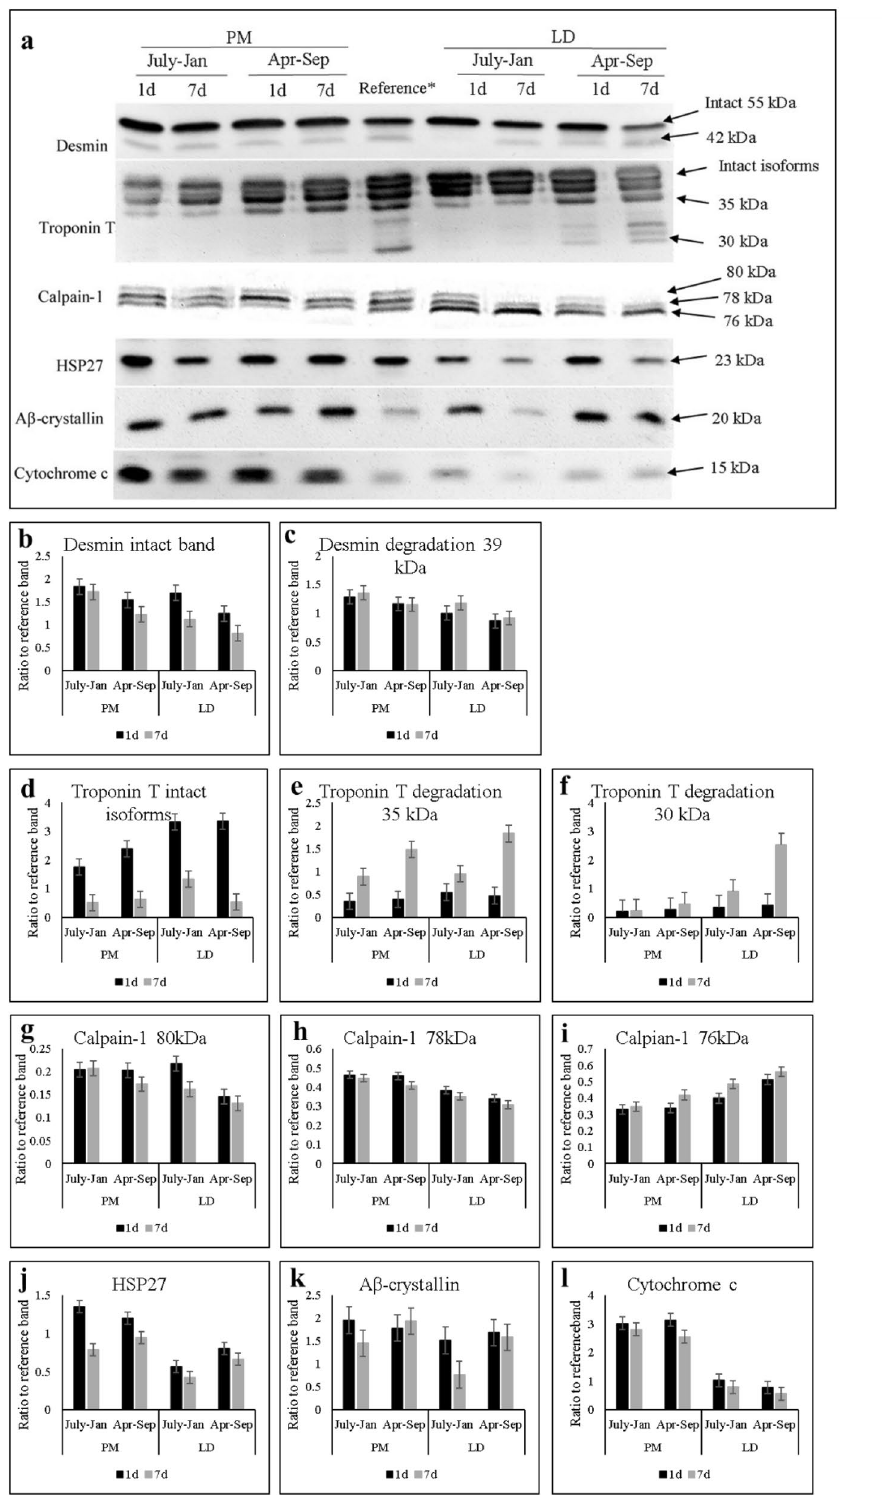
Figure 1. (a) A representative set of western blot images showing 1 day vs. 7 days postmortem change of desmin, troponin T, calpain-1, HSP27, αβ-crystallin and cytochrome c of porcine LD ( longissimus dorsi ) and PM ( psoas major ) muscles with two production replicates. Reference: consistently use a 45 min postmortem LD for calpain-1 and a 7 days postmortem LD for desmin, troponin T, HSP27, αβ-crystallin and cytochrome see supplementary information for the entire western blot images). (b–l) Densitometry analysis of each protein